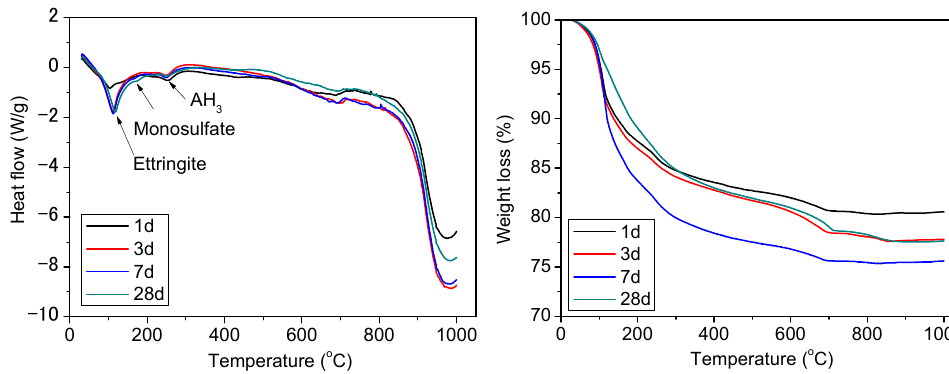
Figure 12. DSC-TG plots of the TCSA cement pastes at 1, 3, 7 and 28 days.